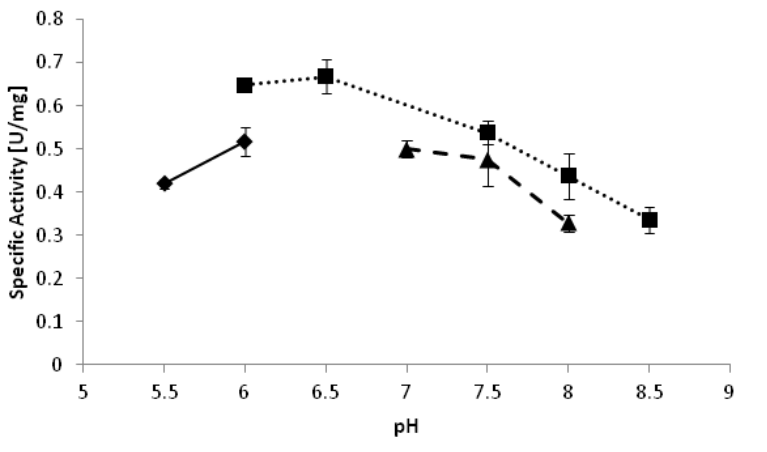
Figure 2. pH optimum of Yl ADH2 catalyzed reduction of 2-octanone.  : citrate; ■: potassium phosphate; ▲: